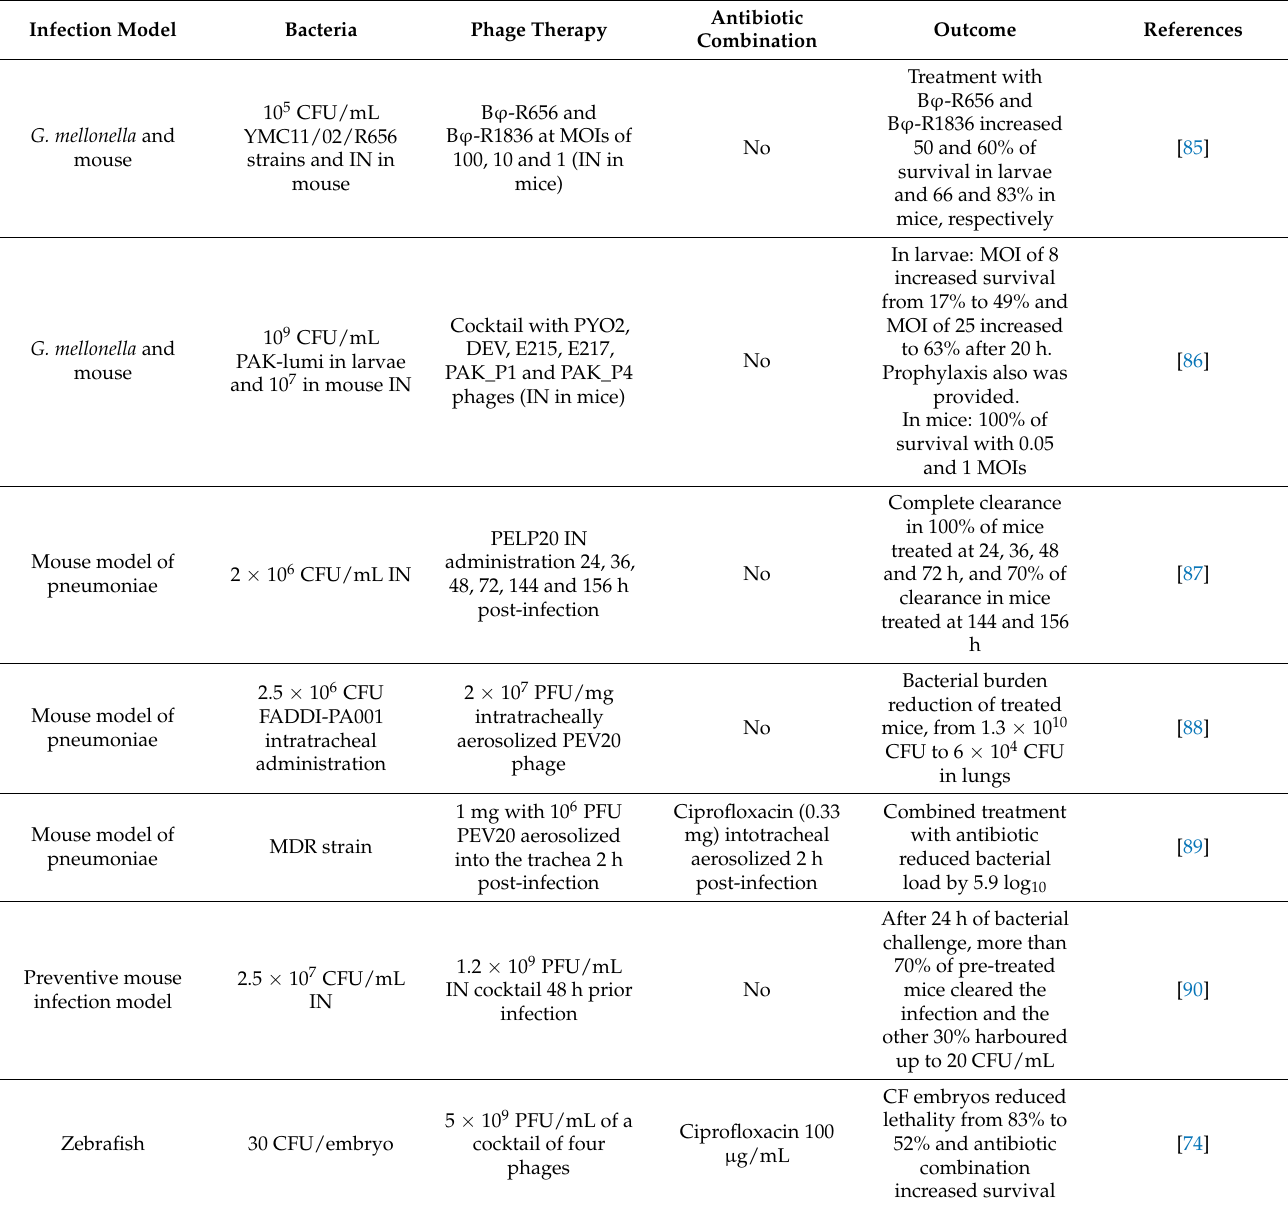
Table 4. Summary of in vivo studies using phage therapy against P. aeruginosa from 2015 to date. Infection